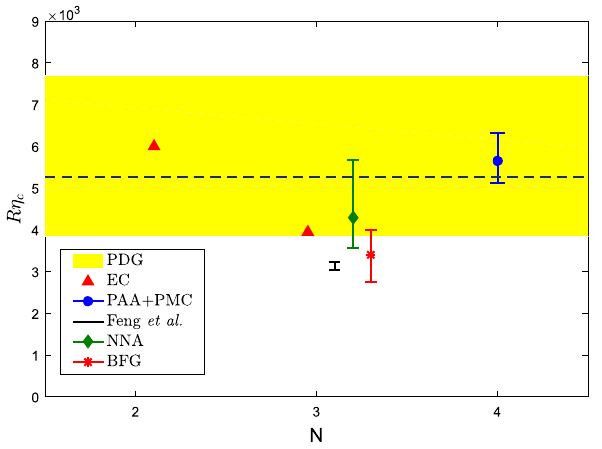
Fig. 3 The R η -ratio under various approaches. “EC” is the exact c prediction by using the known NLO or NNLO PMC series, and “PAA+PMC” is the PAA prediction by using the PMC NNLO series. The error of “PAA+PMC” at the NNNLO level (N=4) is caused by (cid:5)α ( M 2 ) = ± 0 . 0011. As comparisons, the PDG value, the NNLO s Z predictions (N=3) of Feng et al. [10], NNA [11] and BFG [11] are also presented